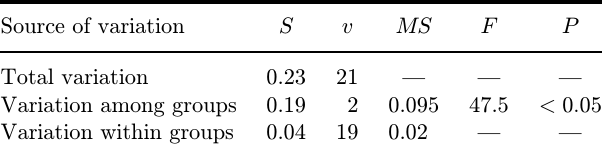
Table 2. Statistics of